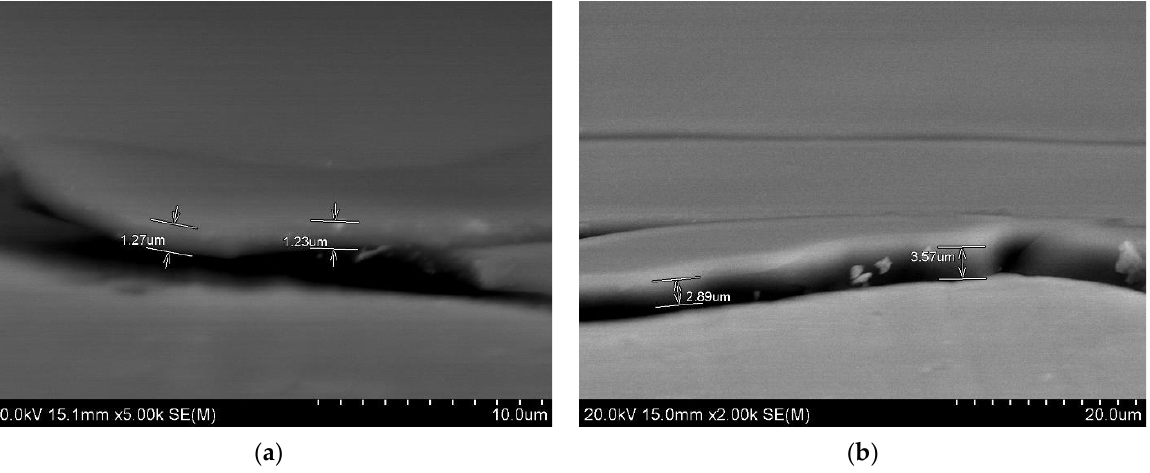
Figure 7. S EM images showing the thickness of ( a )SG1.5 DD, ( b ) SG1.5 TD after 36 min of cavitation Figure 7. SEM images showing the thickness of ( a ) SG1.5 DD, ( b ) SG1.5 TD after 36 min of cavitation test .